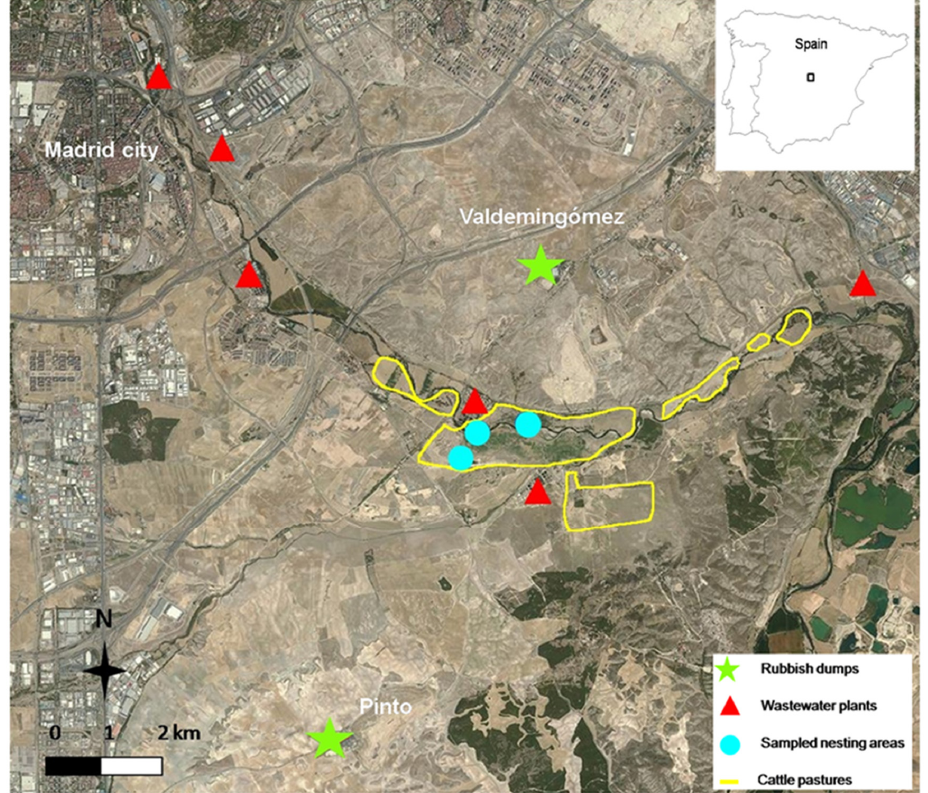
Figure 2. Study area showing the location of the nesting areas of the sampled white stork nestlings and the locations of the two large rubbish dumps, the sewage treatment plants, and the pastures used for cattle ranching along the Manzanares River, Madrid, Spain.